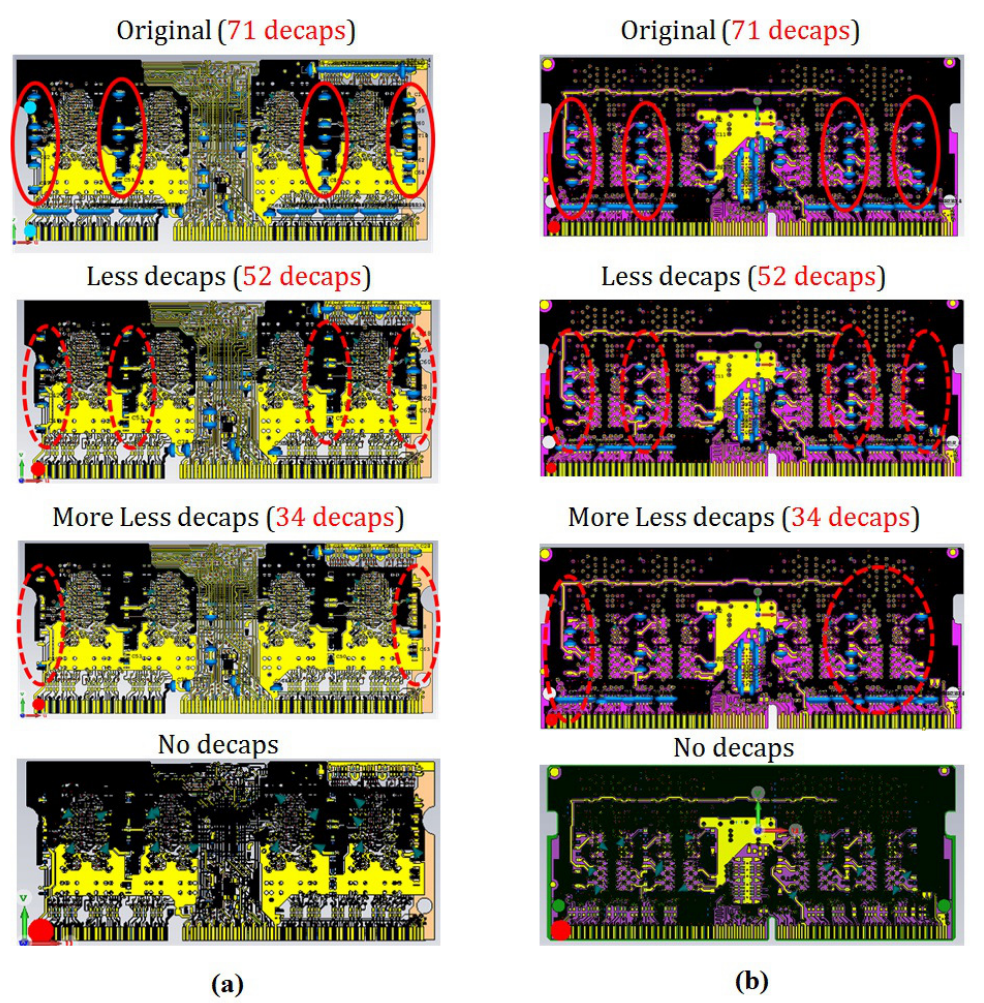
Figure 16. DOE simulation cases to analyze the effect of number of decaps on induced ESD noises: ( a ) DDR3 module cases; and ( b ) DDR4 module